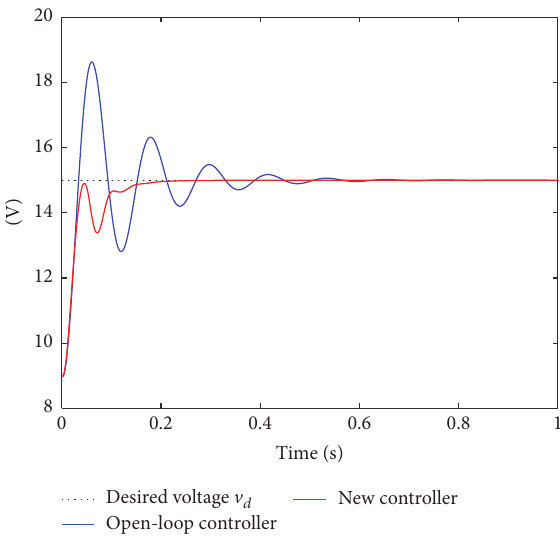
Figure 2: Capacitor voltage V (𝑡) obtained for the new controller (17) and (18) and the open-loop controller